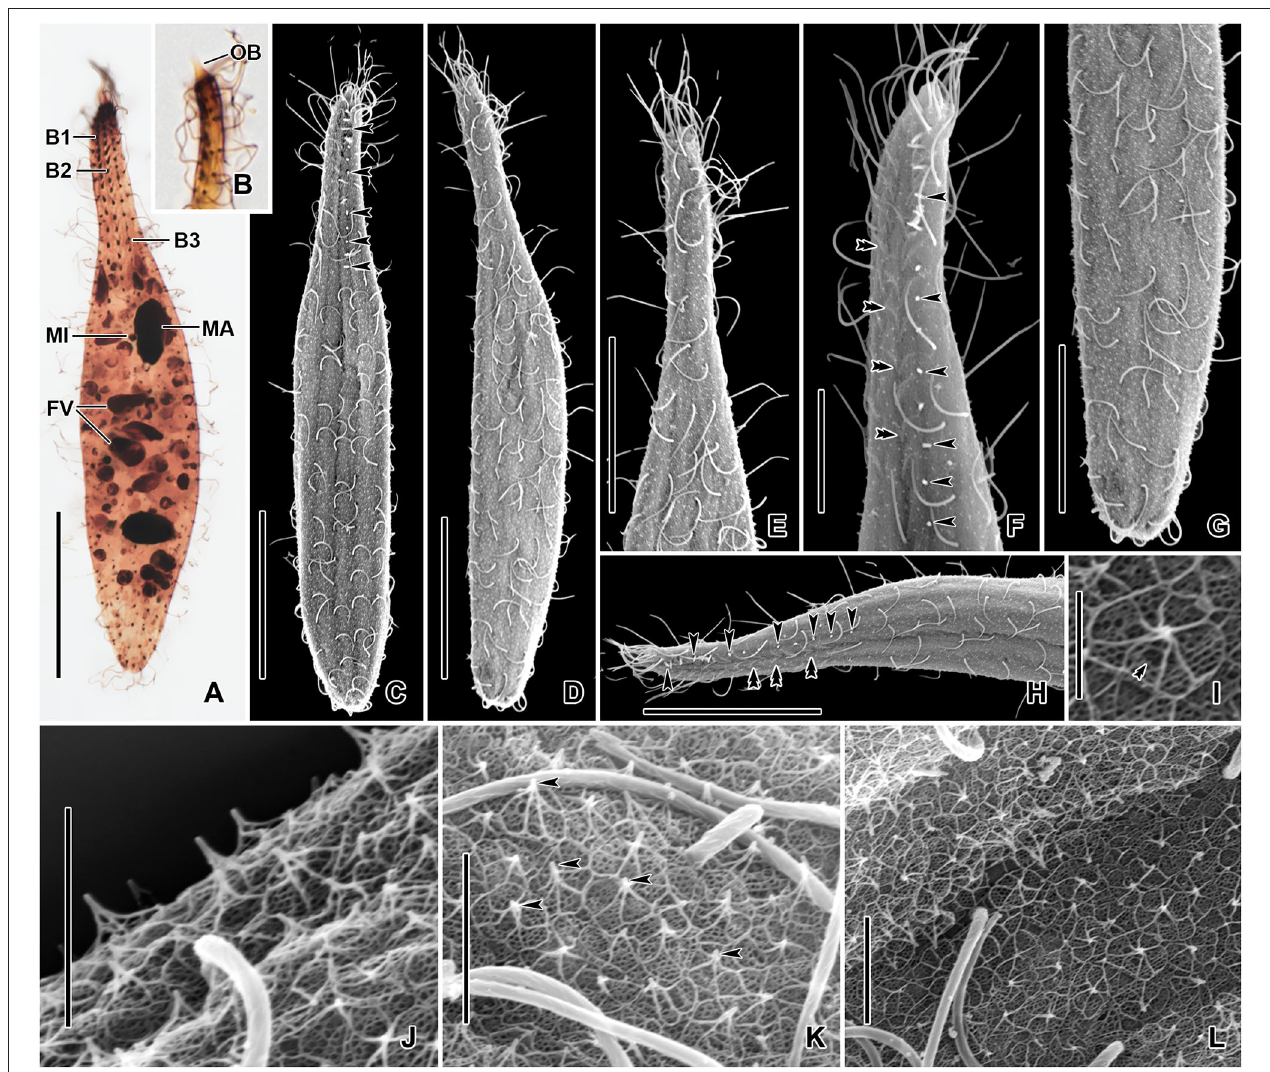
FIGURE 3 | Monolamellophrya terricola gen. nov., sp. nov. after protargol impregnation (A,B) and in the scanning electron microscope (C–L) . (A) Dorsal view of the holotype specimen showing the dorsal brush rows, the nuclear apparatus, and the cytoplasm packed with food vacuoles. (B) The narrow, conical oral bulge of a paratype specimen. (C–H) Dorsal (C,F,H) and ventral (D,E,G) views, showing the cortex covered with epicortical scales of type II indicated by the white dots, which represent the cone structure made by the fine arcs. Arrowheads mark the bristles of the dorsal brush row 3. Cilia of brush rows 1 and 2 V-like spread and covered by epicortical scales (double arrowheads). (I–L) Lepidosomes of type II showing the fine arcs fusing together and forming a rosette-like structure in the top view. The double arrowhead in (I) marks the depression in the middle area of the baseplate. B1–3, dorsal brush rows; FV, food vacuoles; MA, macronucleus; MI, micronucleus. Scale bars = 30 µ m (A,C,D,H) , 20 µ m (E,G) , 10 µ m (F) , 2 µ m (J,K) , and 1 µ m (I)